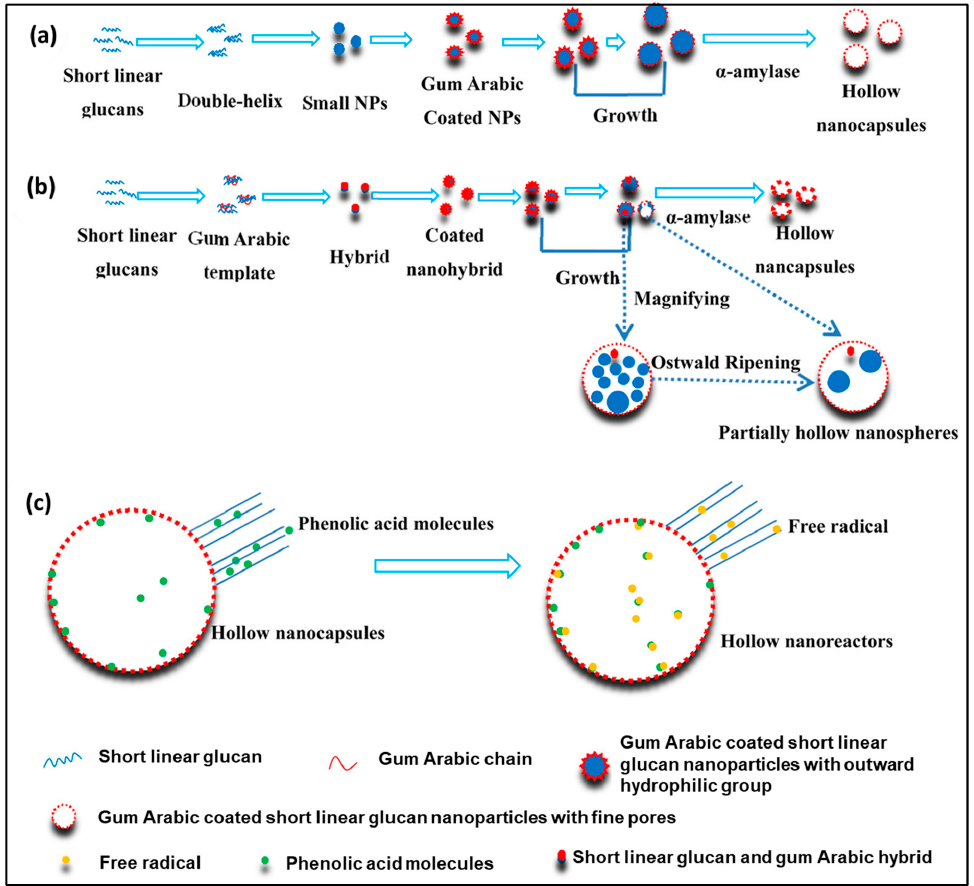
Figure 6. Graphical presentation of the fabrication of hollow gum arabic coated short linear glucan